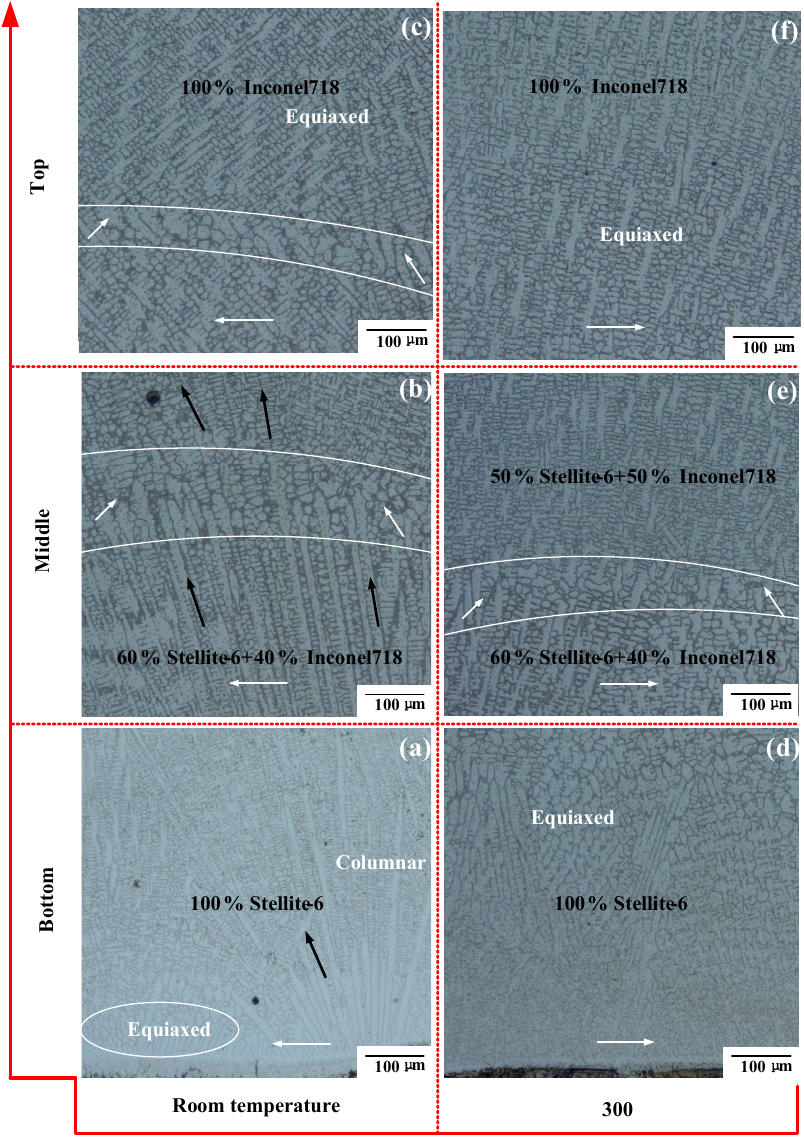
Figure 8. Dendritic morphology along the longitudinal section of the LMD FGM samples: ( a ) Bot- tom at room temperature, ( b ) Middle at room temperature, ( c ) Top at room temperature, ( d ) Bottom at 300 °C, ( e ) Middle at 300 °C, ( f ) Top at 300 °C.